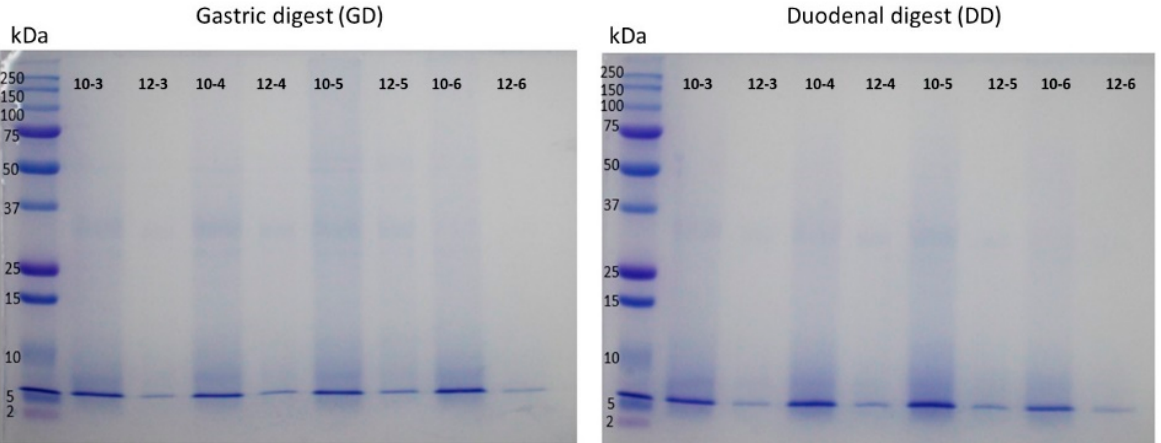
Figure 3. Analysis by SDP-PAGE of gastrointestinal digest of cricket protein concentrate (CPC). The uncropped western blot figures were presented in Figure